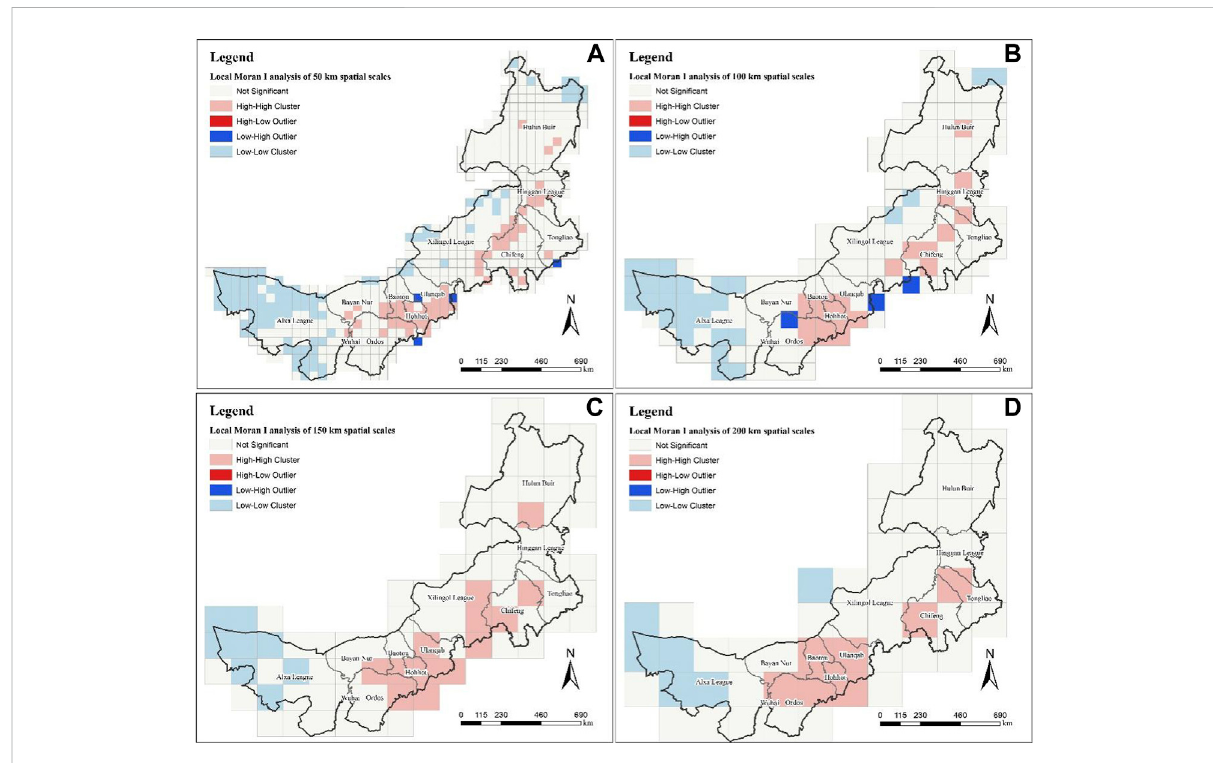
FIGURE 3 Local Moran ’ s I analysis at different scales. (A) is the result at the spatial scale of 50 km; (B) is 100 km; (C) is 150 km; (D) is 200